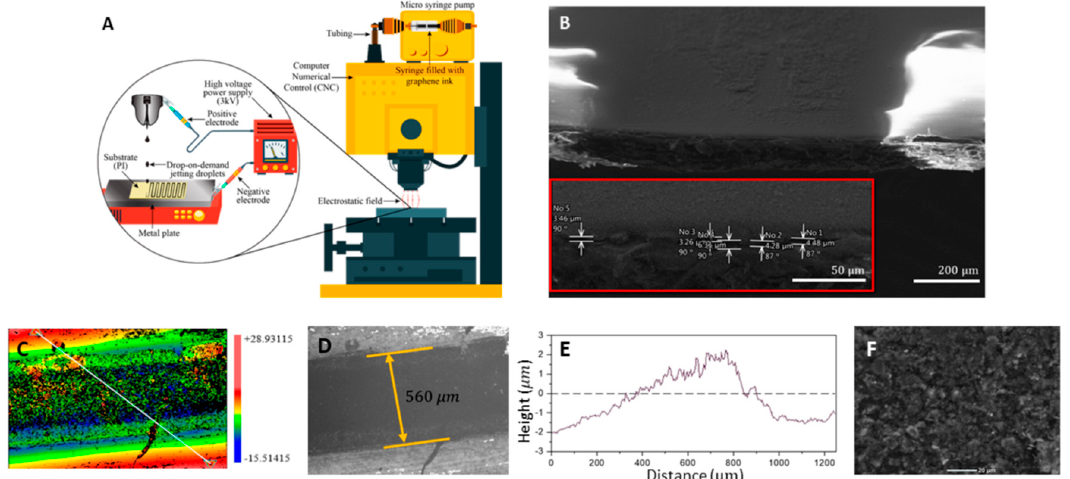
Figure 11. ( a ) DOD printer for the printing of graphene suspension; ( b ) SEM image of printed pattern Figure 11. ( A ) DOD printer for the printing of graphene suspension; ( B ) SEM image of printed pattern cross-sectional view; ( c ) image of printed graphene suspension a contour in which the average height cross-sectional view; ( C ) image of printed graphene suspension a contour in which the average height was measured through the white line. ( d ) Sample print section (20× magnification). ( e ) height vs. was measured through the white line. ( D ) Sample print section (20 × magnification). ( E ) height vs. distance of the sample line in ( c ). ( f ) SEM image of the printed graphene suspension top view after distance of the sample line in ( C ). ( F ) SEM image of the printed graphene suspension top view after annealing. Reproduced from [187], with permission from the authors, annealing. Reproduced from [187], with permission from the authors, 2020.